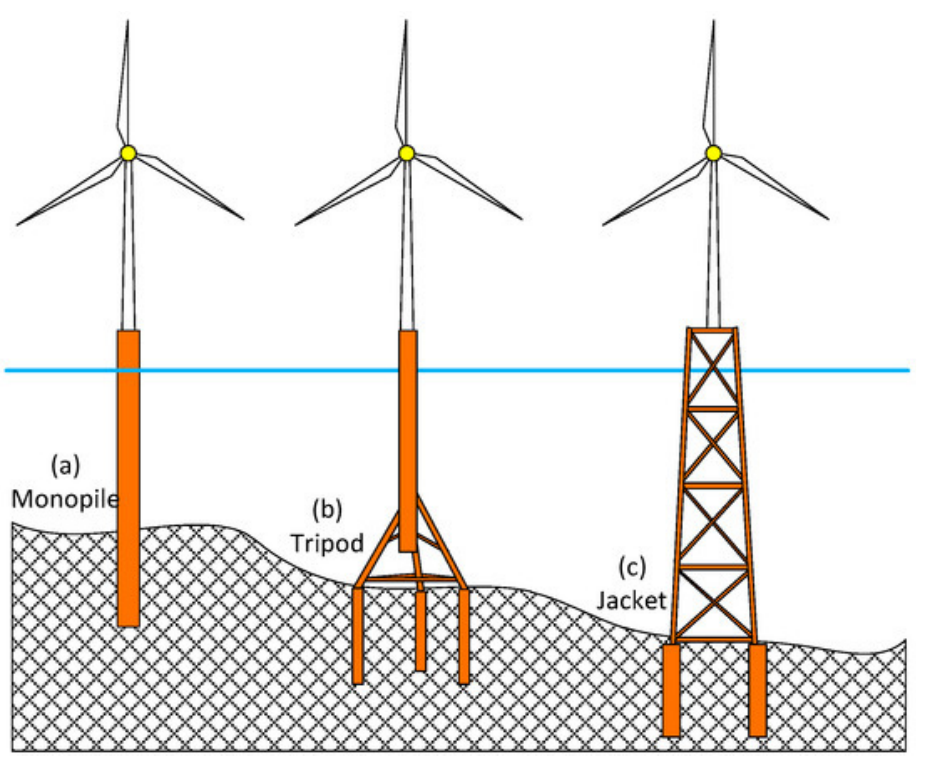
Figure 2. Types of Fixed Offshore Wind Turbines: ( a ) Monopile; ( b ) Tripod; ( c ) Jacket Substructures [22].